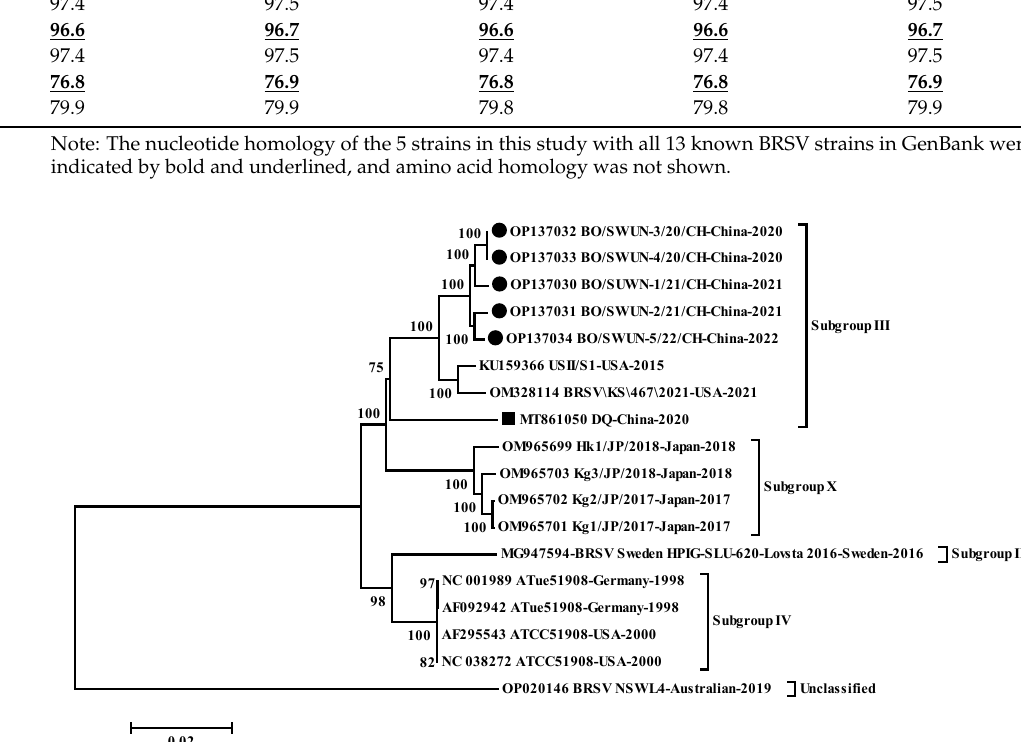
Figure 4. Phylogenetic tree based on the nucleotide sequences of the complete genome was compared and clustered by MEGA 7.0 software. The phylogenetic tree was constructed using the neighbor-joining method (1000 replicates). ● represents 5 complete genome sequences of BRSV strains from this study, represents the complete genome of other isolates in China.